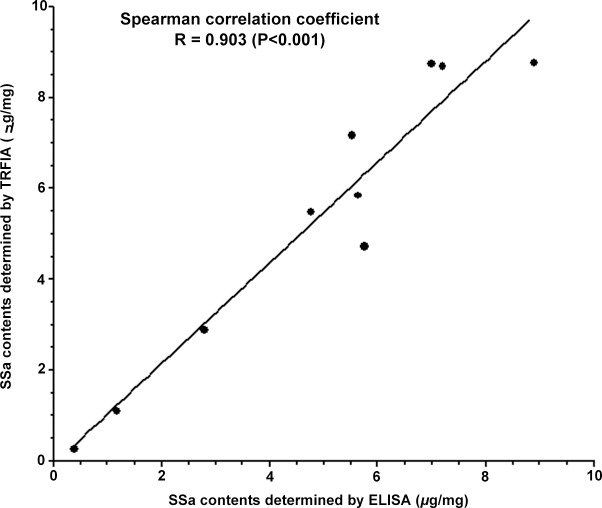
Correlation of SSa contents in Chaihu crude drug samples determined by TEFIA and ELISA.SSa contents in Chaihu crude drug samples determined by TRFIA (Y-axis) were well correlated with those determined by ELISA (X-axis), with a Spearman correlation coefficient (R) of 0.903 (P < 0.01).